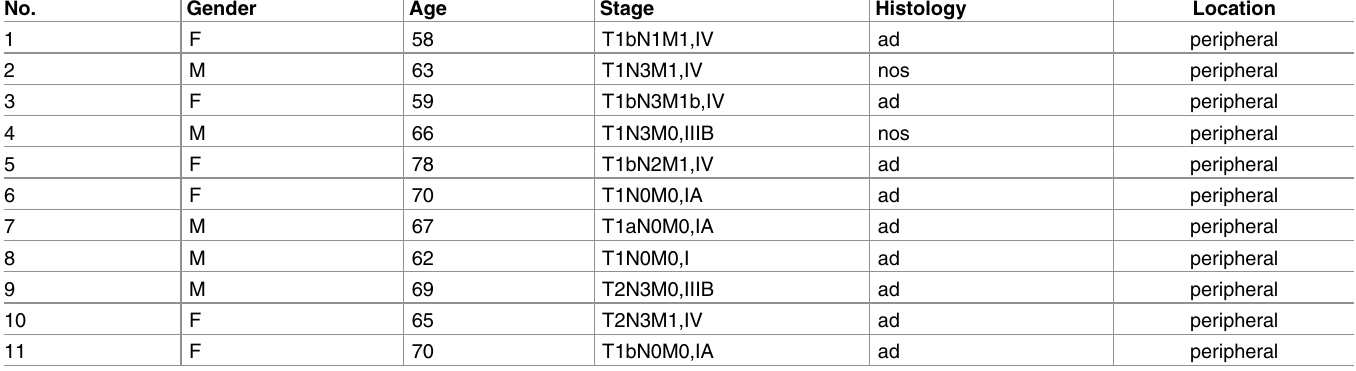
Table 1. Patient